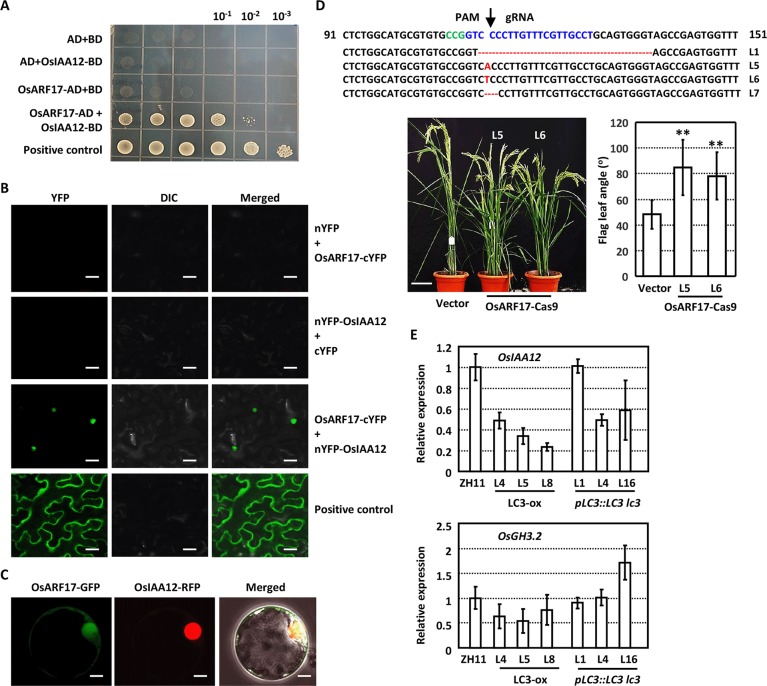
OsIAA12 interacts with OsARF17 to regulate leaf inclination.(A) Yeast-based two-hybrid analysis reveals the interaction between OsIAA12 and OsARF17. Yeast transformants were diluted 101, 102, and 103 times and grown on synthetic dropout (-Leu/-Trp/-His/-Ade) plates for 4 days. (B) Split-YFP assays show the OsIAA12-OsARF17 interaction in planta. Fusion proteins OsARF17-cYFP and nYFP-OsIAA12 were expressed in N. benthamiana and fluorescences were observed. nYFP and cYFP were used as negative control. Bar = 30 μm. (C)OsIAA12 co-localizes with OsARF17 in cell nucleus. OsARF17-GFP and OsIAA12-RFP fusion protein were transiently co-expressed in rice protoplasts and representative images are shown. Bar = 5 μm. (D) Four homozygous knockout rice lines at OsARF17 locus induced by Crispr/Cas9 were confirmed by sequencing. PAM (green) and gRNA (blue) sequences are highlighted. Mutations including deletions (red dots) and insertions (arrows). Phenotypic observation (bottom left, bar = 10 cm) and measurement of the leaf inclination at 10 days after heading (bottom right) show that OsARF17-Cas9 plants present enlarged leaf angle. Data are shown as means ± SD (n>30) and statistically analyzed by using Student’s t-test (**, p<0.01). (E)The expression of OsIAA12 (upper) and OsGH3.2 (bottom) in LC3 overexpression and lc3 plants with complemented LC3 expression. Transcription levels were normalized with that of Actin and relative expressions were calculated by setting the expression level in ZH11 as “1.0”. Experiments were biologically repeated three times and data are presented as means ± SE.